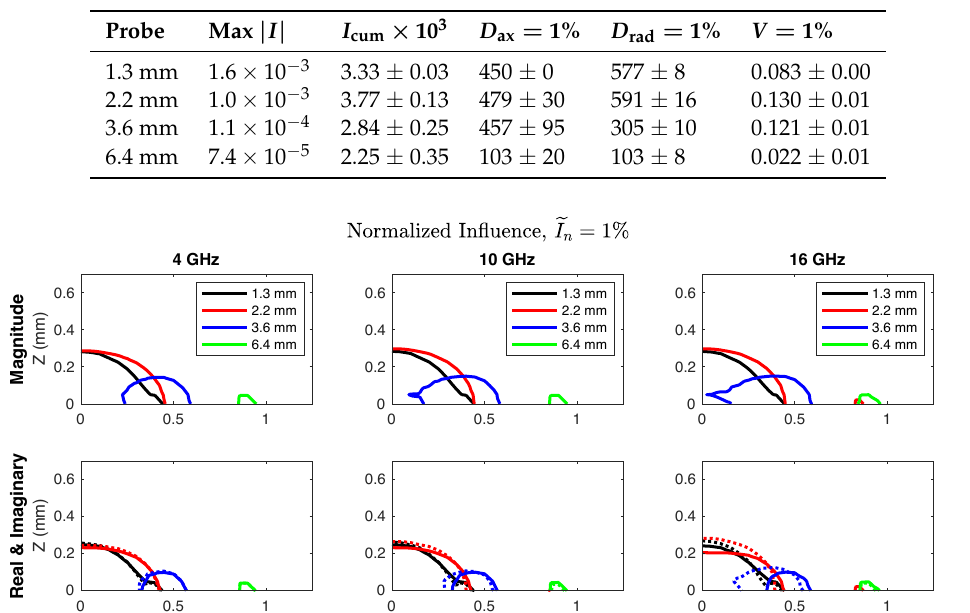
Table 3. Measurement volume metrics by coaxial probe diameter. Values expressed as mean ± standard deviation over 0.5–20GHz. Diameters expressed in micrometers. Volume expressed in cubic millimeters. Normalized metrics are dimensionless.